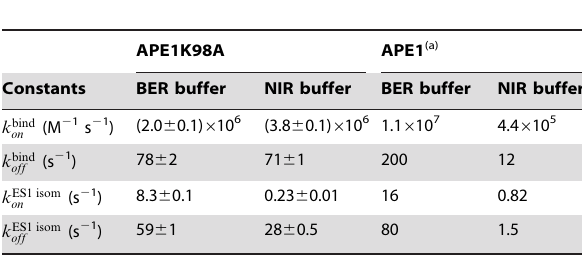
Table 1. Rate constants of APE1K98A and APE1 binding with undamaged C/G